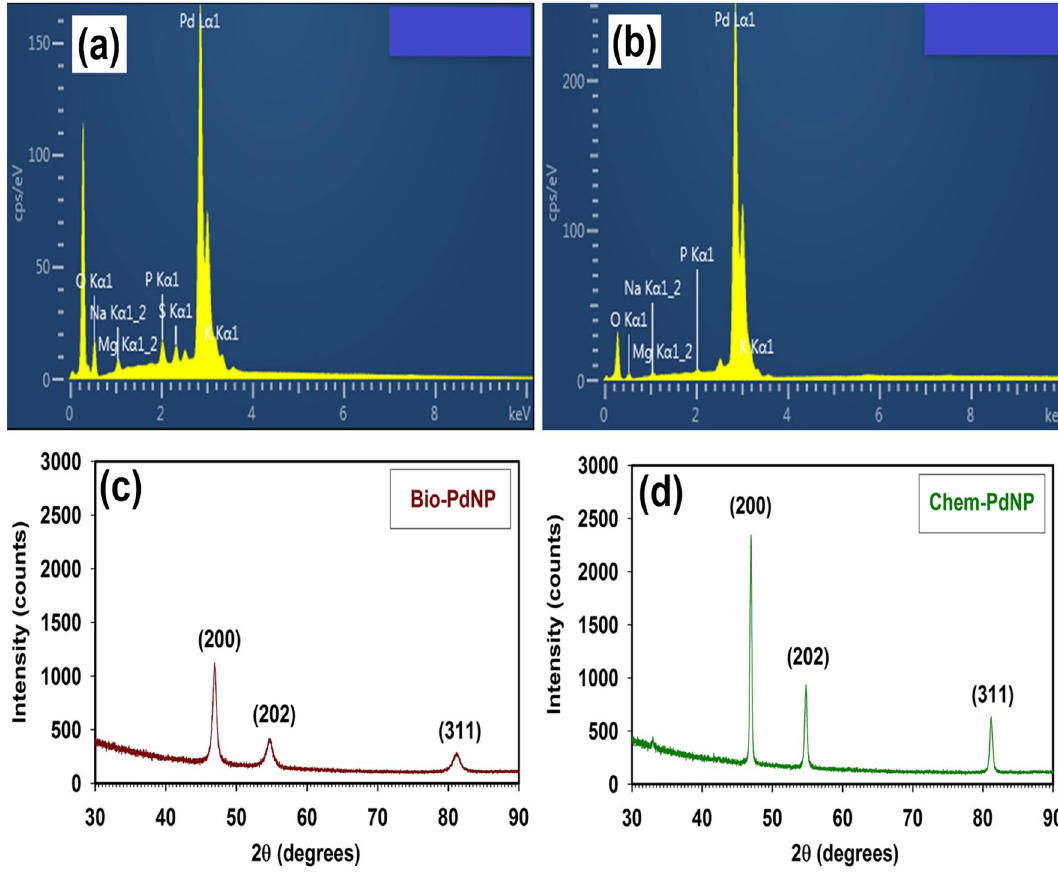
Figure 5. Elemental composition analysis by EDS of ( a ) Bio-PdNPs and ( b ) Chem-PdNPs; and XRD patterns of ( c ) Bio-PdNPs and ( d ) Chem-PdNPs.